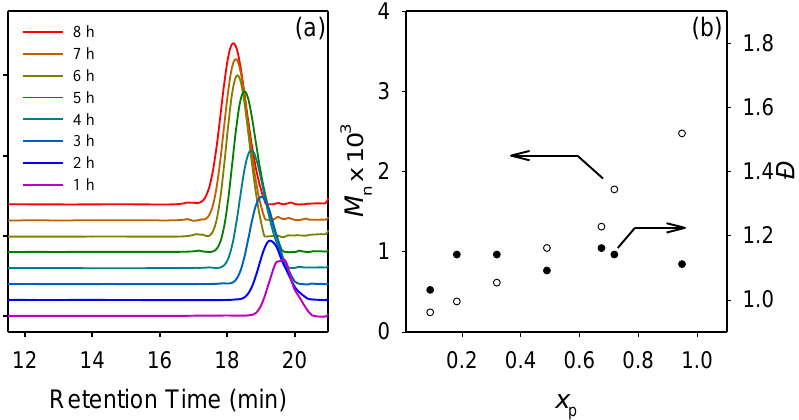
Figure 6. ( a ) GPC curves of PCL and ( b ) plots of M n and Ð versus monomer conversion ( x p ) collected at different intervals. Conditions: DMC-EAA = 10 mg ([ Zn ] 0 = 30 mM), [ CL ] 0 = 9 M, [ CL ] 0 /[ SB ] 0 = 20, T p = 160 °C.